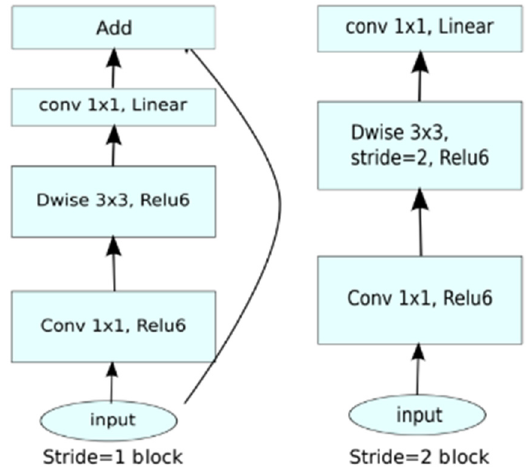
Figure A4. Blocks of MobileNetV2 architecture [38].